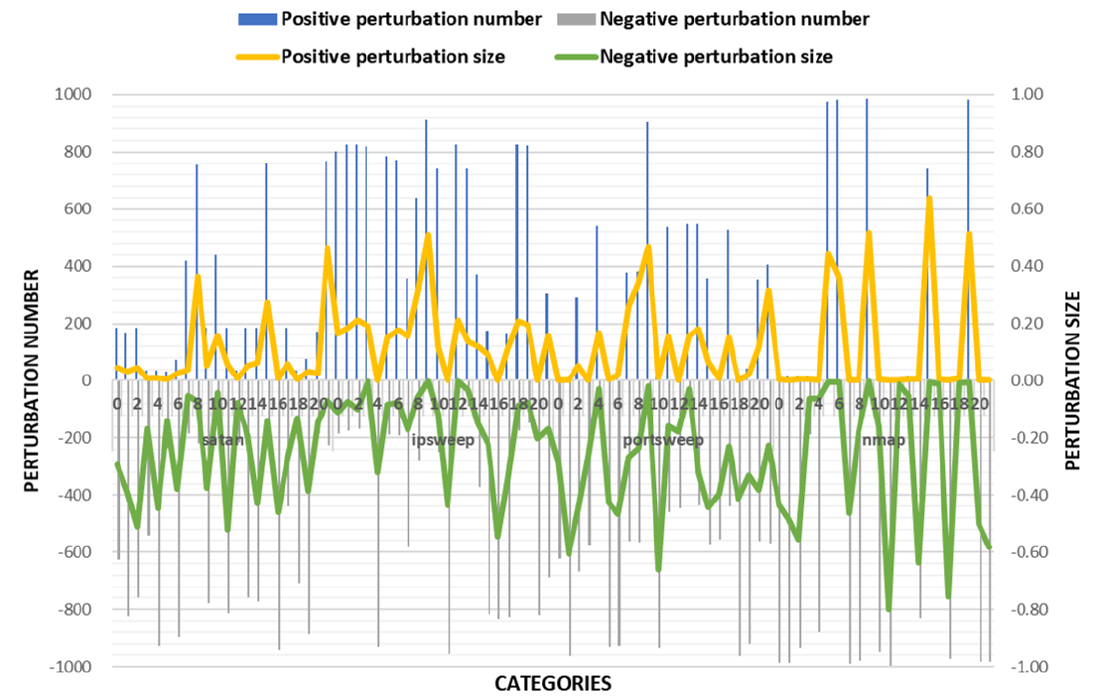
Figure 4. Comparison of the number of perturbation features and the size of the disturbance in TLTD-II. Table 6. The results of TLTD-II. The data in the table is the average of the 1000 sample test results.